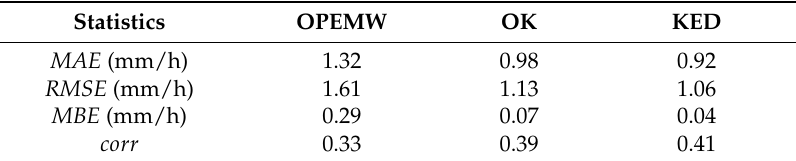
Figure 5. Comparisons between rain gauge observations, the original OPEMW SRI and the downscaled data for the date 13 Feb 2018 06:58 UTC. The white circles represent the SRI measured by rain gauges and the orange circles represent the OPEMW SRI. The symbol size represents the SRI in mm/h. Table 5. As in Table 3 but for data from 13 Feb 2018 at 06:58 UTC.